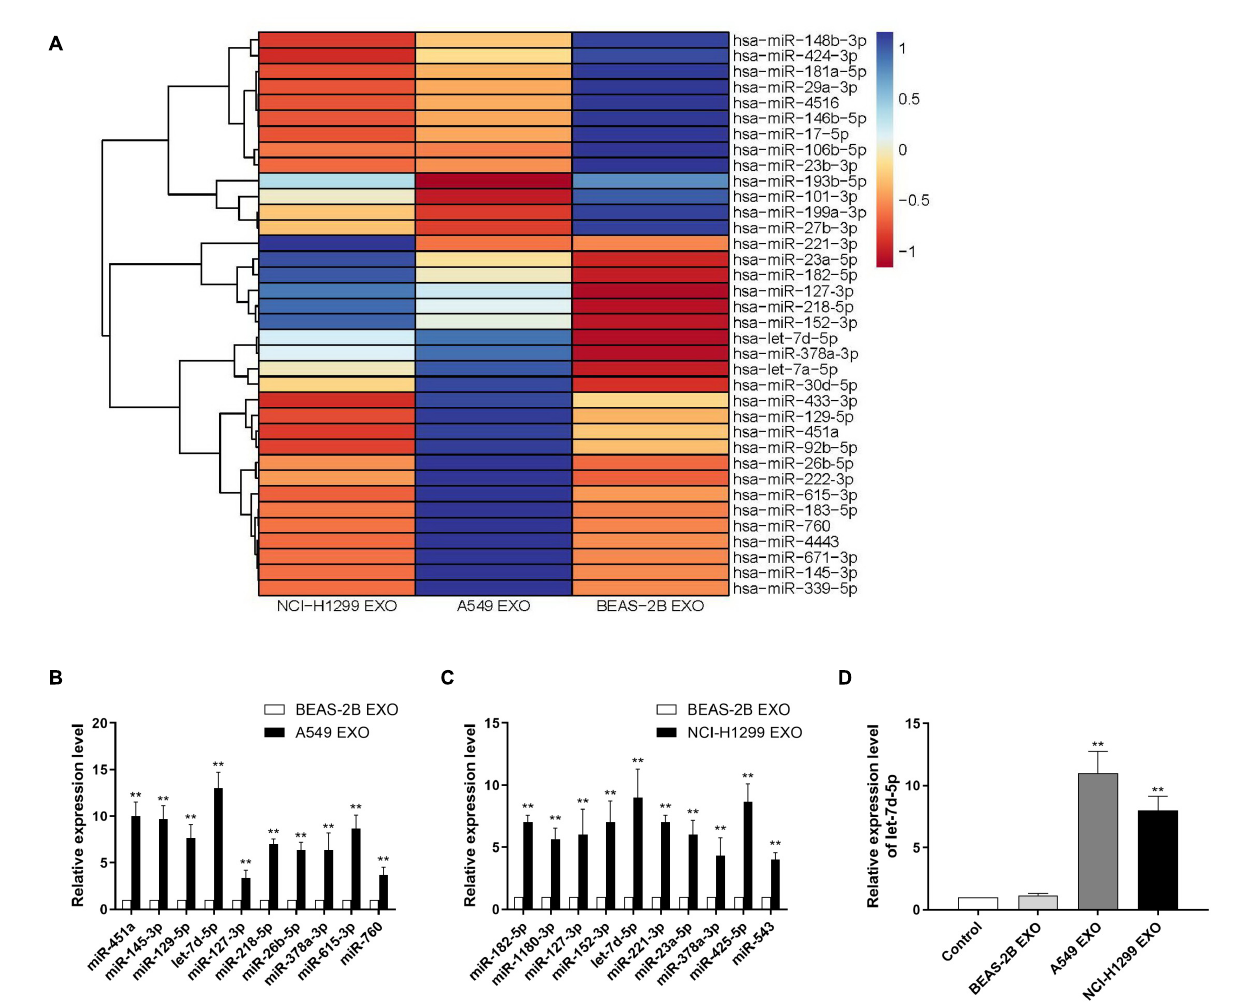
FIGURE 2 | Identifying exosomal microRNAs secreted by NSCLC lines. (A) The expression profile of miRNAs in exosomes secreted by NSCLC lines. Exosomes from non-cancerous cells (BEAS-2B) were used as a normalization control. Blue color denotes higher expression, and red color denotes lower expression relative to the control. (B) qRT–PCR analysis revealing the expression of miRNAs in A549 cell–derived exosomes. (C) qRT-PCR analysis revealing the expression of miRNAs in NCI-H1299 cell–derived exosomes. (D) The expression of let-7d-5p in A549 and NCI-H1299 groups was up-regulated after treated DRG neuron cells